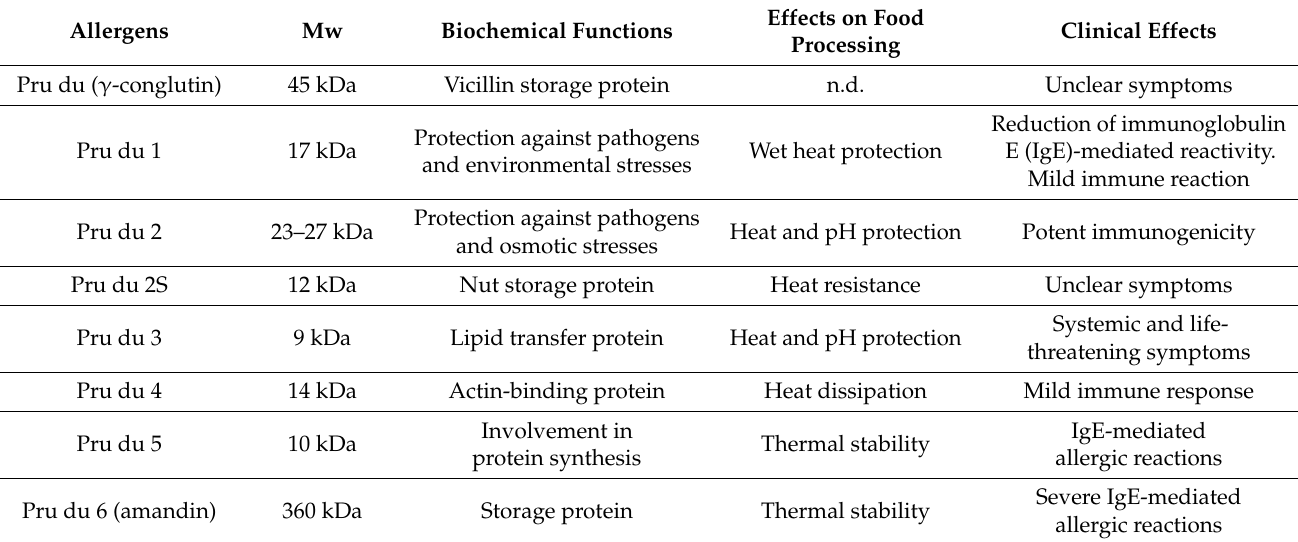
Table 3. Almond-derived food allergens and their clinical